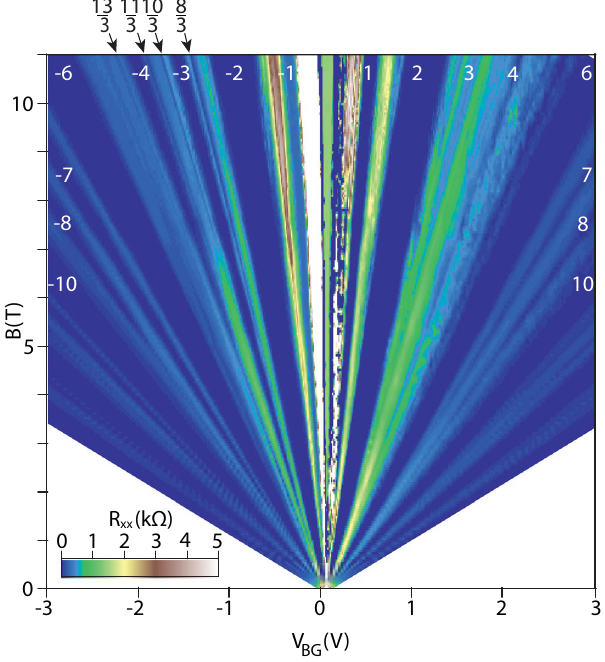
Figure 9. Fan diagram for R xx ( V . B ) in monolayer graphene up to 11 T from experiment 10 . The noticeable property is the closeness in value of R xx of the FQHE features for fractions with denominator 3 for n = 1 with those for IQHE, which supports the FQHE single-loop braid correlations in corresponding states, similar to the case of